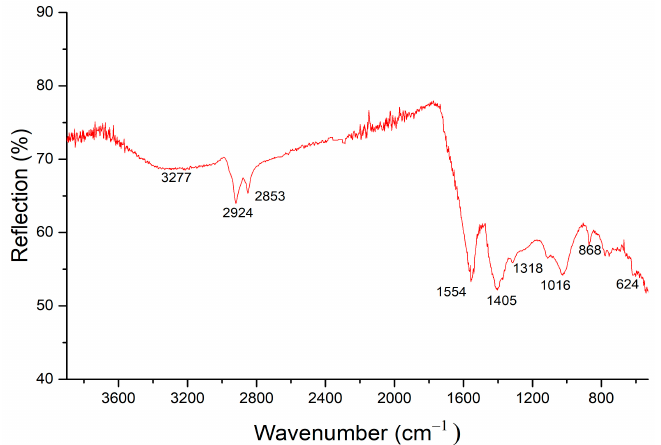
Figure 8. FTIR spectrum of the EOP biochar sample.